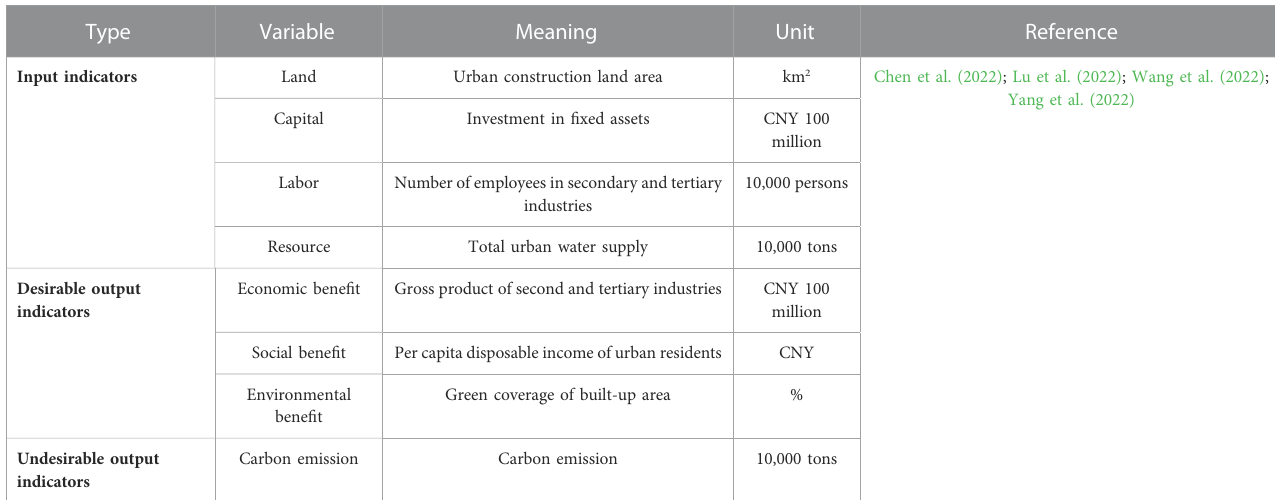
TABLE 1 ULUE index